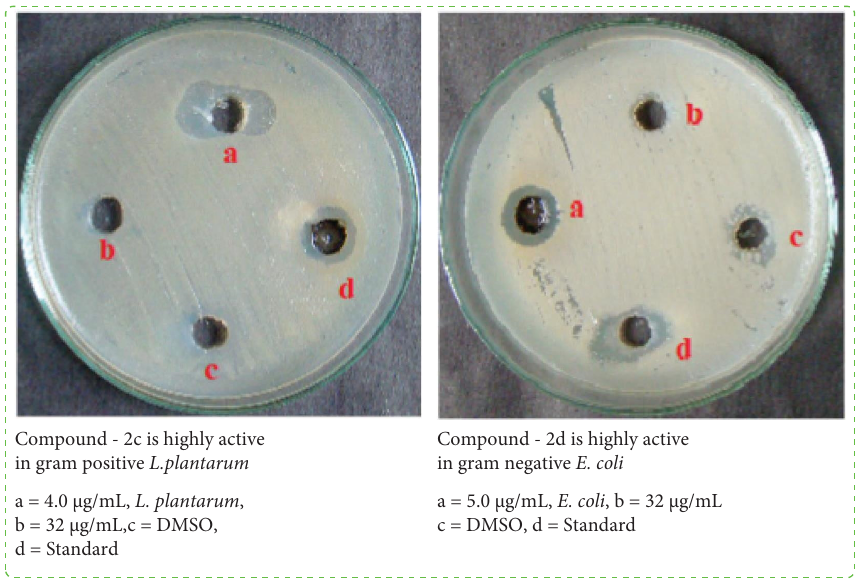
Figure 9: Antibacterial assay of highly active compounds with